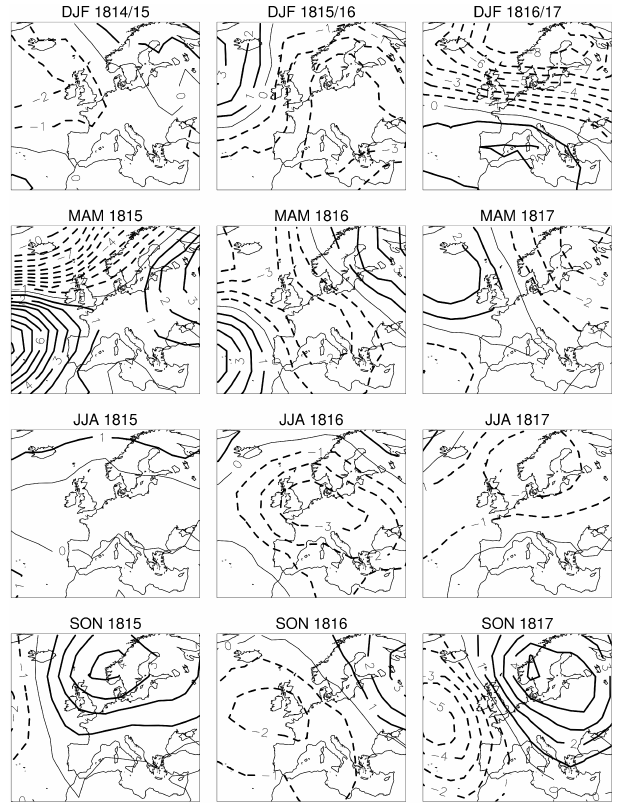
Figure 5. Seasonal SLP anomalies (in hPa) in Europe for winter (DJF), spring (MAM), summer (JJA) and autumn (SON) for the years 1815–1817 (reference period 1961–1990), reconstructed by Küttel et al. (2010).